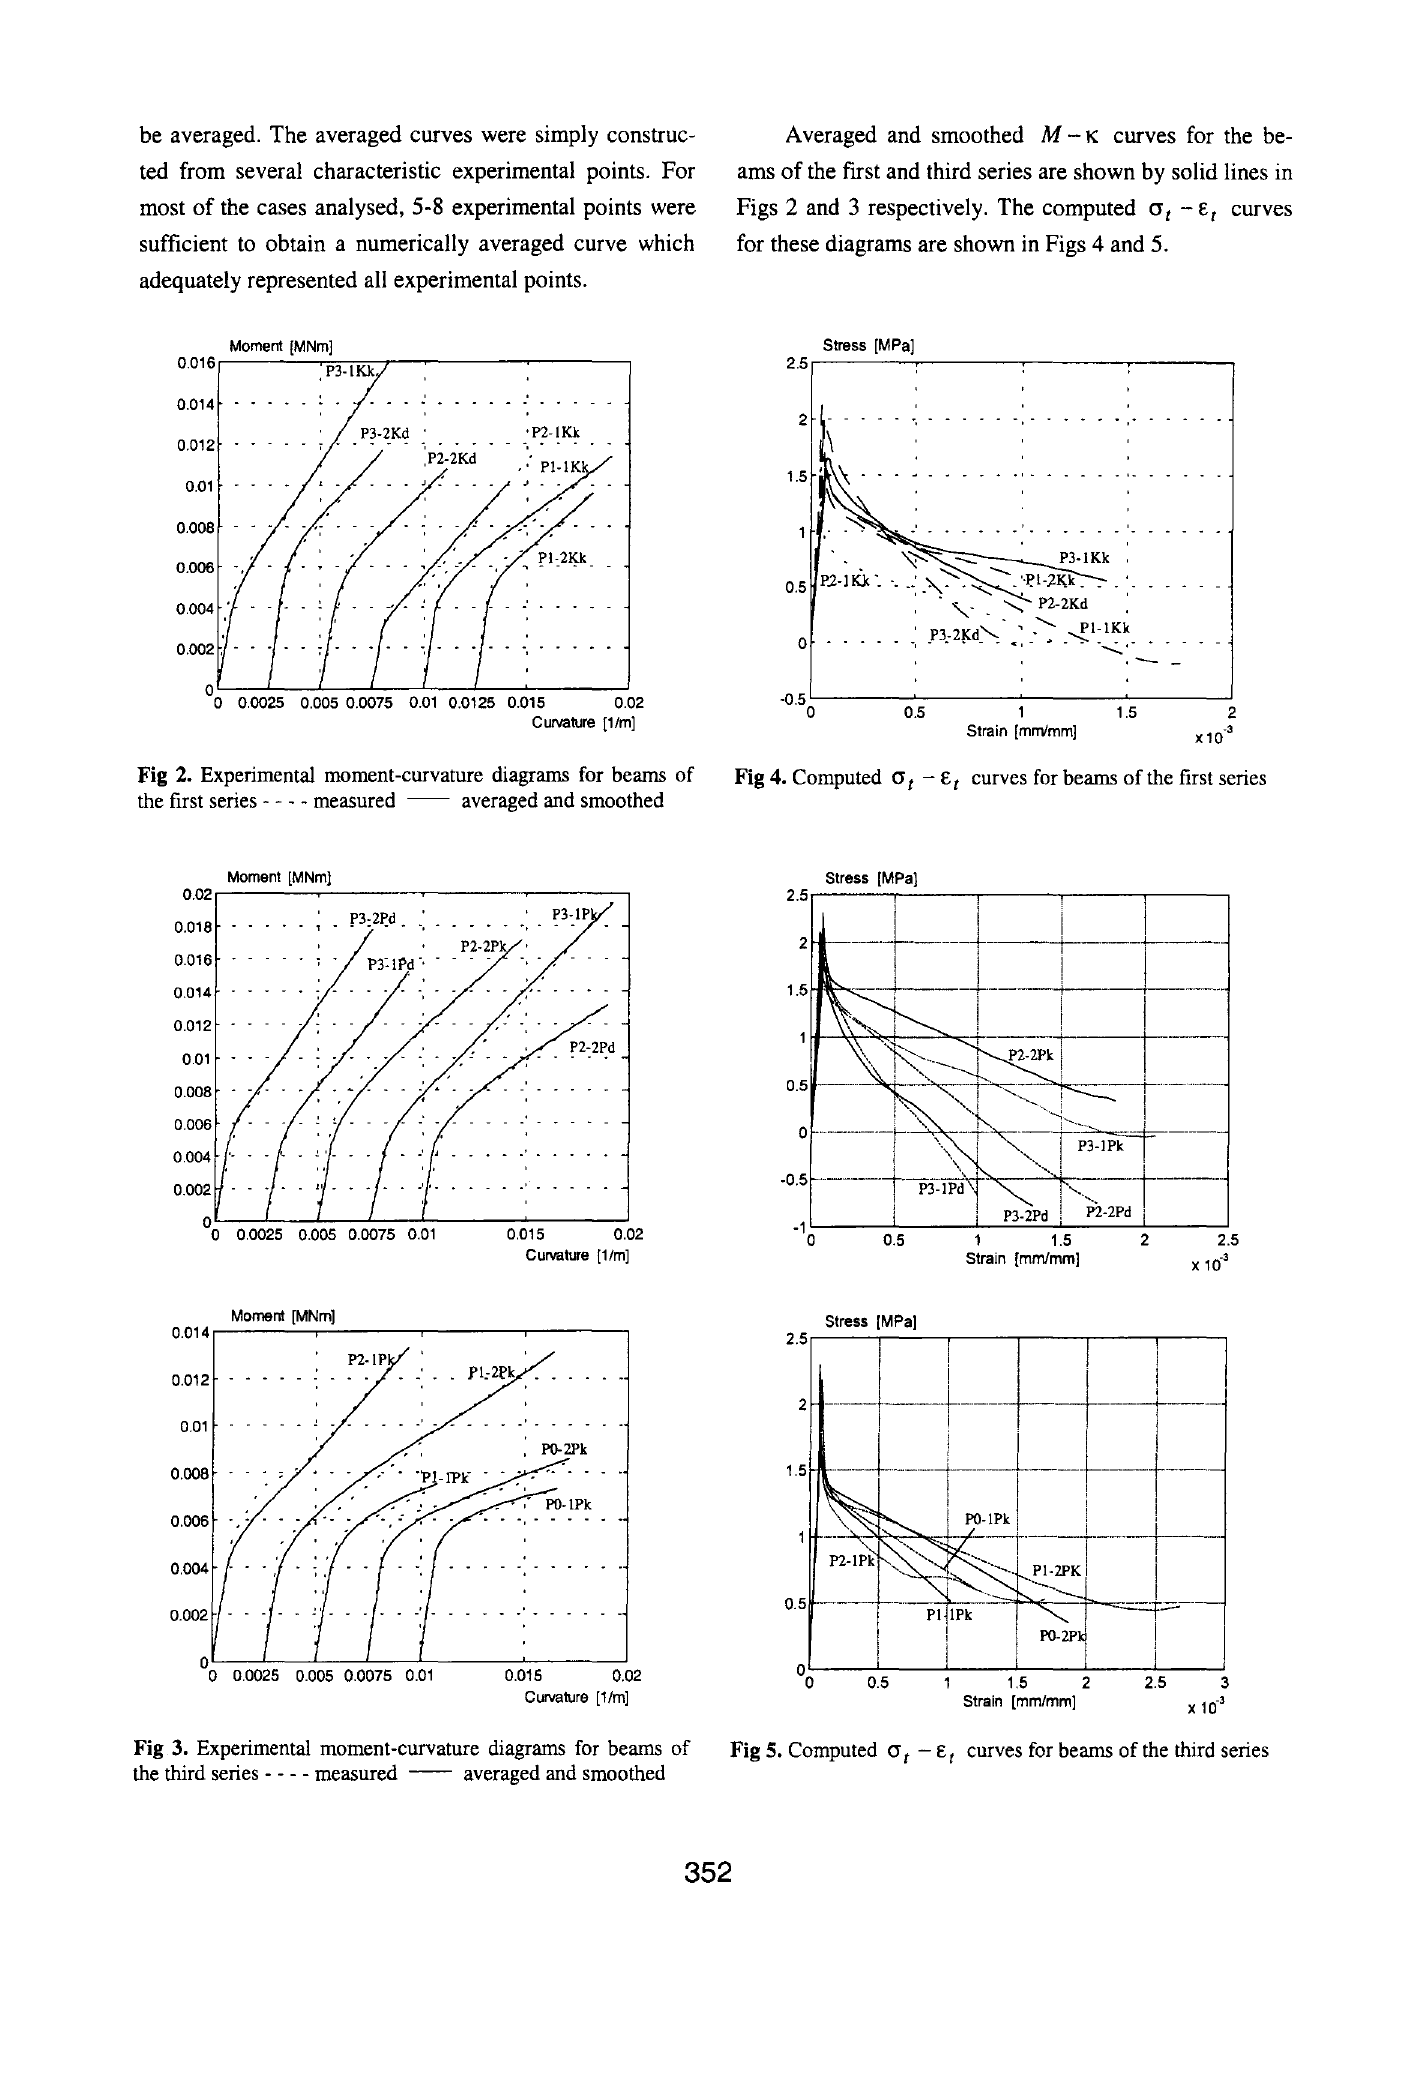
Fig 3. Experimental moment-curvature diagrams for beams of the third series - - - - measured -- averaged and smoothed